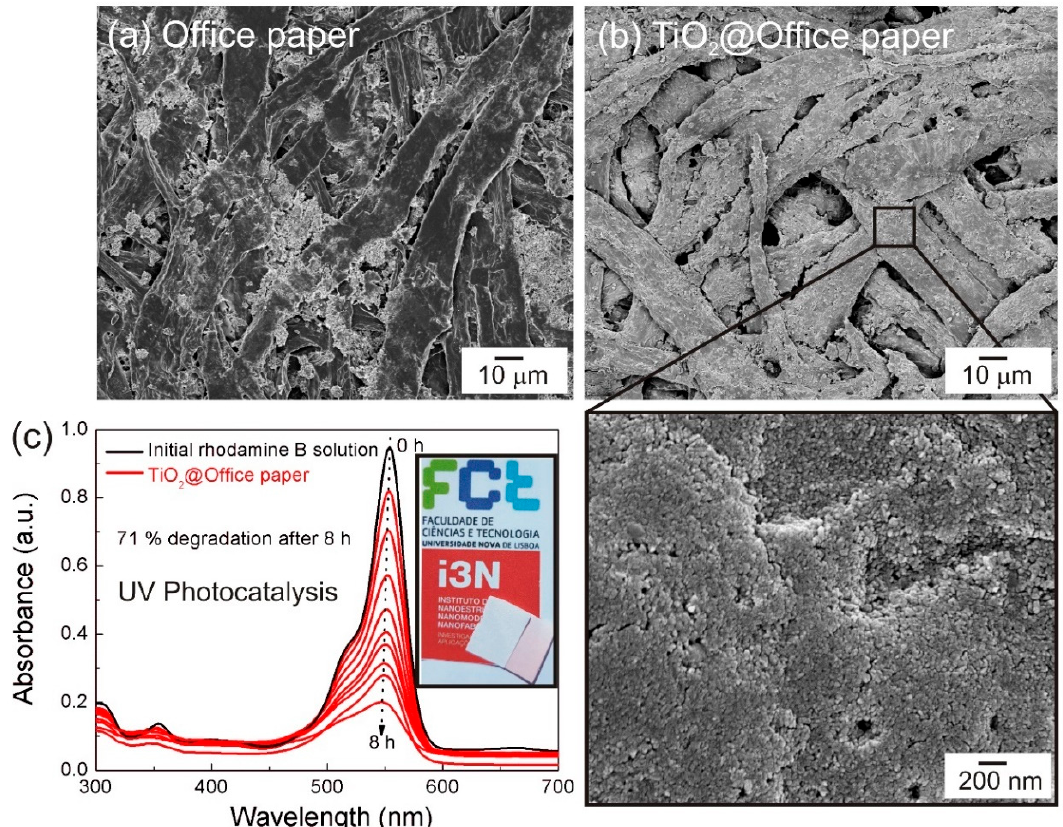
Figure 9. SEM images showing ( a ) the pristine office paper and ( b ) after a microwave-assisted hydrothermal synthesis. The inset magnifies the TiO 2 nanostructured film grown on office paper substrate. ( c ) Rhodamine B absorbance spectra at different UV exposure times using the TiO 2 nanostructured film on office paper together with the image of the photocatalytic paper before and after (pinkish color) experiments (71% of degradation after 8 h using 3 lamps of 95 W aligned in parallel, from Osram, with an emission wavelength of 254 nm, and Rhodamine B solution of 5 mg/L). Photocatalytic experiments based on [19].